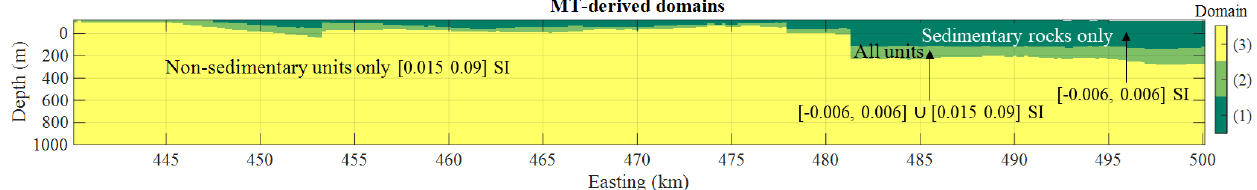
Figure 10. MT-derived domains for cases with (i) sedimentary units only, (ii) sedimentary and non-sedimentary units and (iii) non- sedimentary units only. The magnetic susceptibilities for the different domains are also